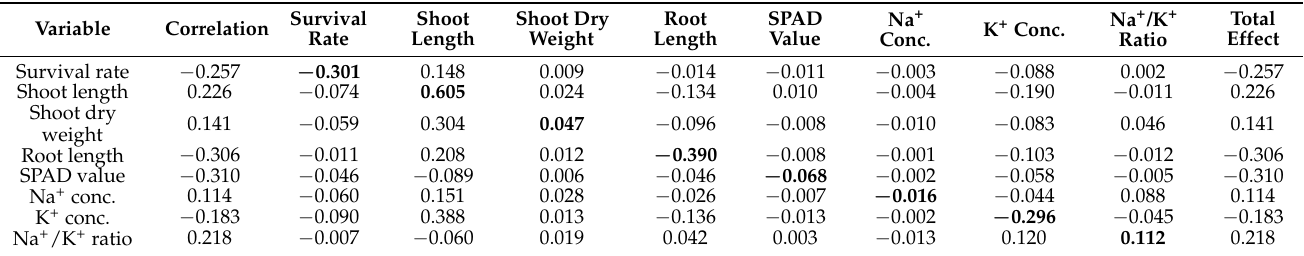
Table 1. Correlation and path coefficients for direct and indirect effects of survival rate, shoot length, shoot dry weight, root length, SPAD value, Na + concentration, K + concentration, Na + /K + ratio on SES scores in an F 2:3 population of a cross between Akundi (salt-tolerant) and BR49 (salt-sensitive) grown under salt stress at seedling